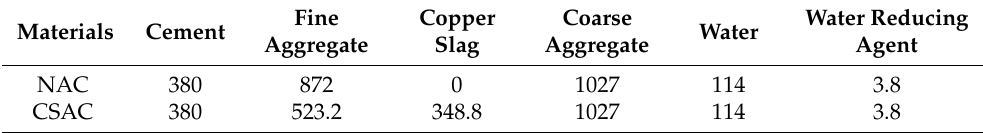
Table 11. Concrete batching table kg/m 3 .